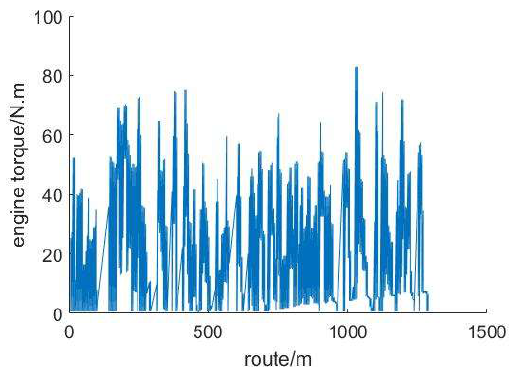
Figure 17. Logic gate control engine torque.